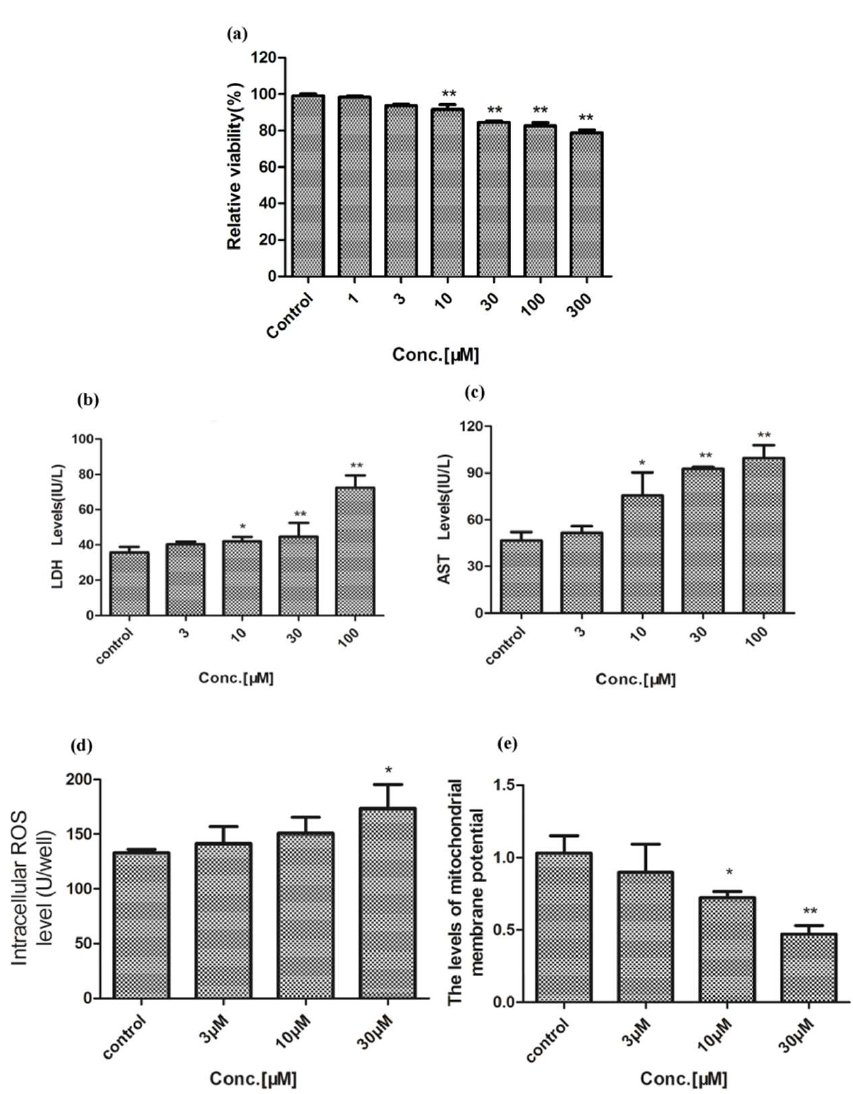
Figure 3. Toxicity of triptolide on primary rat hepatocytes. ( A ) The relative viability after treatment with a variety of concentrations of triptolide. ( B ), ( C ), ( D ) The effects of triptolide on LDH, AST, and ROS productions in rat primary hepatocyte, respectively. ( E ) MMP levels after treatment with different concentrations of triptolide. Compared with the control group, * p < 0.05, ** p < 0.01.